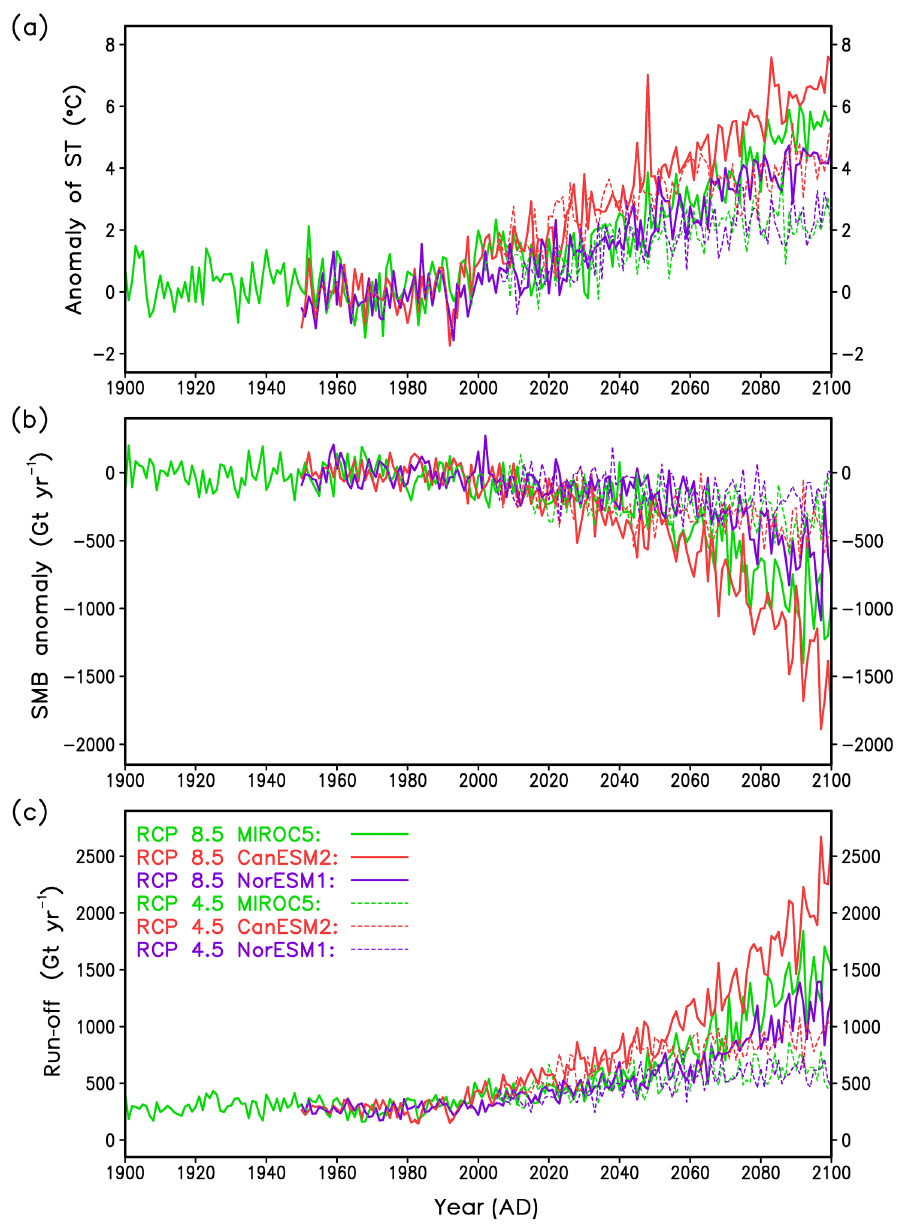
Figure 3. Forcings derived from the MAR regional model. (a) Anomaly of annual average surface temperature, (b) total annual SMB anomaly and (c) total annual runoff. Anomalies are taken with respect to the period 1961–1990 from the respective CMIP5 models. RCP 8.5 scenarios are indicated by the solid lines, while RCP 4.5 scenarios are shown by the dashed